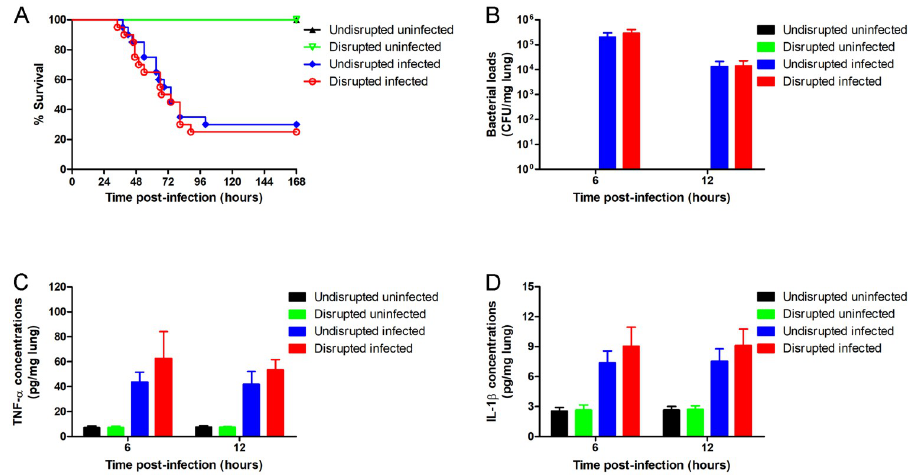
Fig 5. Gut microbiota disruption does not obviously affect the pulmonary resistance to S . pneumoniae in TLR4-deficient mice. TLR4-deficient mice were treated with broad-spectrum antibiotics or autoclaved saline, and infected intra-nasally with 2.3 × 10 8 CFU of S . pneumoniae . (A) The survival was observed for 7 days (n = 20 per group). (B) Bacterial load, and (C) TNF- α and (D) IL-1 β concentration per mg lung tissue were determined 6 hours and 12 hours after infection (n = 6 per group). CFU, colony-forming units. Data are presented as means ± SD. Analyzed with the log-rank test or unpaired Student’s t test.